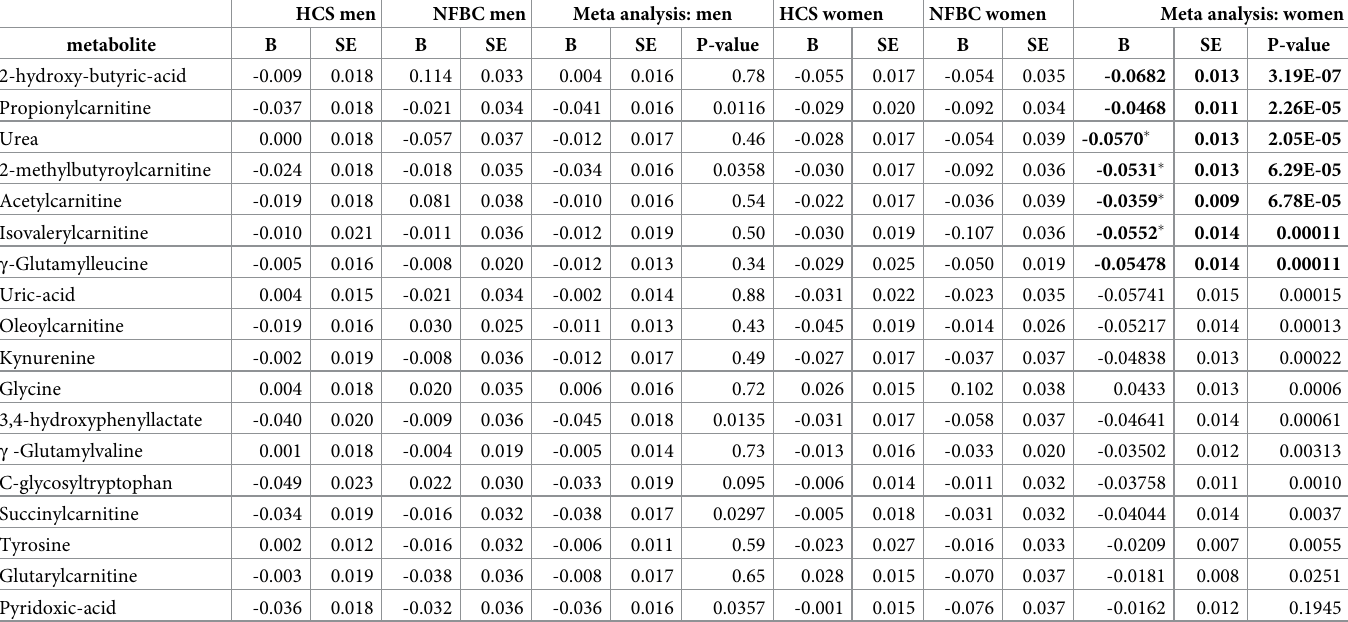
Table 3. Metabolites associated with birthweight (adjusted for age and BMI) in both sexes from all 3 cohorts.